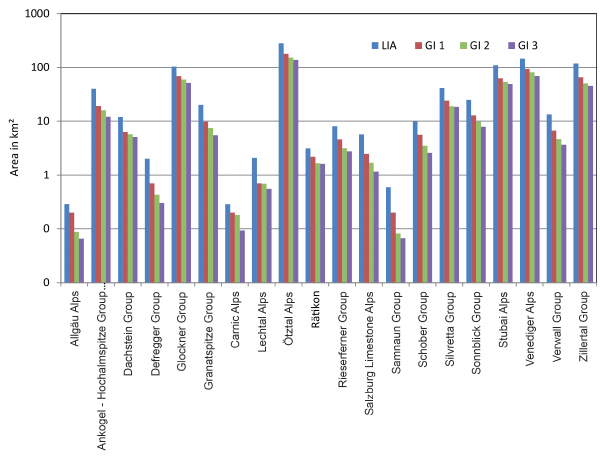
Figure 9. Glacier areas for specific mountain groups in GI LIA to GI 3.